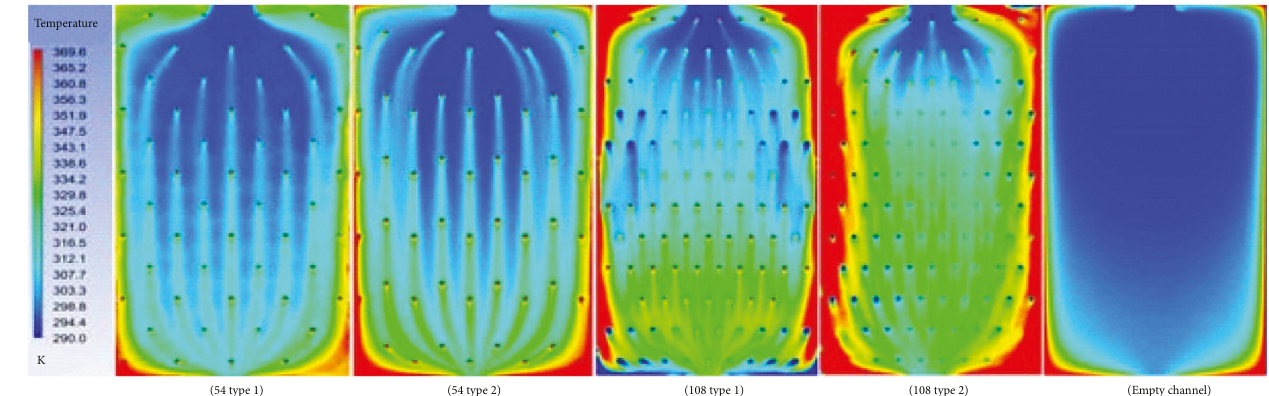
Figure 19: Temperature contours at